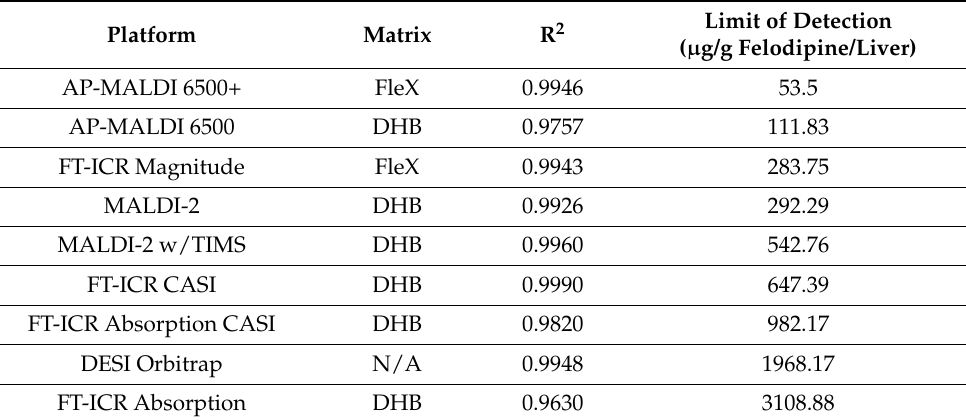
Table 1. Comparison of lowest limit of detection across the imaging platforms, adjusted to 20 µ m 2 pixels. While 3 matrices were used in the initial experiment, DHA did not provide the lowest LoD for felodipine. R 2 values of the linear regression are also included, with most R 2 > 0.99, but none lower than 0.96.